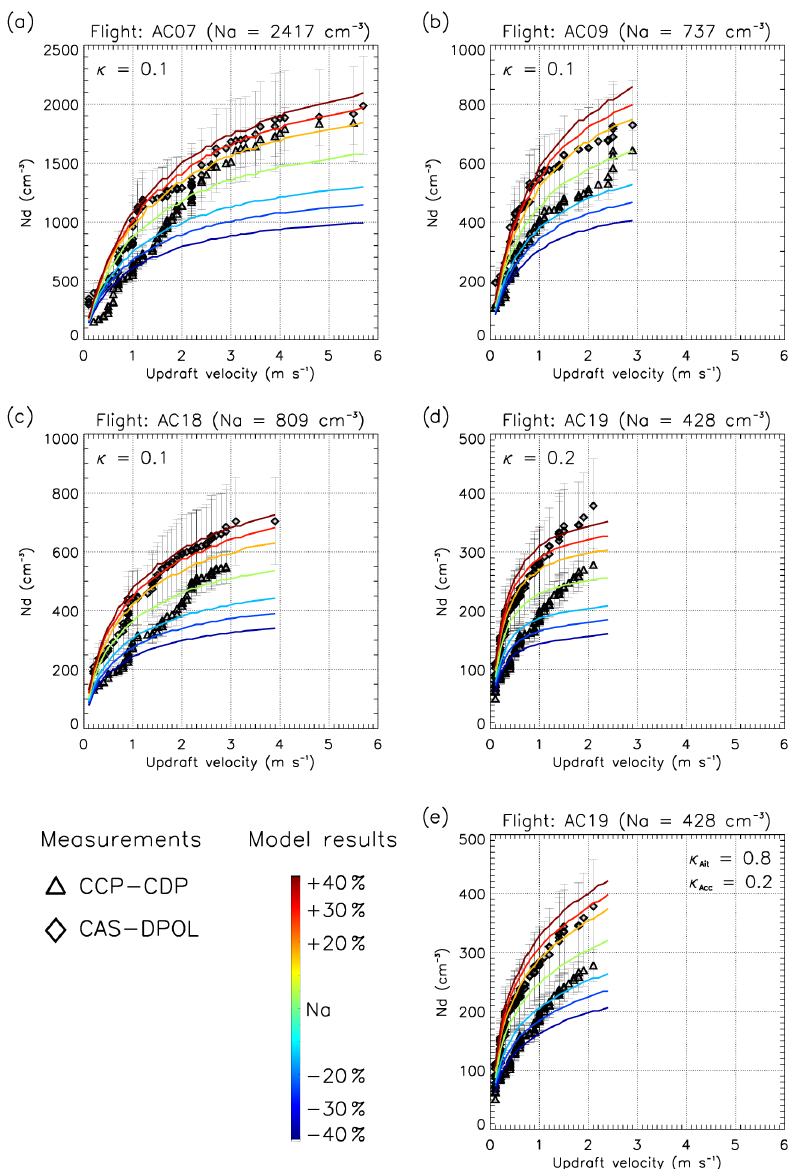
Figure 5. Cloud droplet number concentration ( N d ) as a function of updraft velocity near cloud base of convective clouds during flights: (a) AC07, (b) AC09, (c) AC18, (d) , and (e) AC19. The measured updraft velocities are based on the “probability matching method” (PMM) using the same percentiles for updraft velocity and N d,m (Sect. 3.1). The black diamond and triangle symbols represent N d,m near cloud base with the CAS-DPOL and CCP-CDP probes, respectively. Measurement uncertainties (indicated by error bars) are ∼ 21% and ∼ 10% for CAS- DPOL and CCP-CDP data (Braga et al., 2017a). The lines show N d,p assuming the uncertainty range of N a measurements, colored-coded by (cid:49)N a